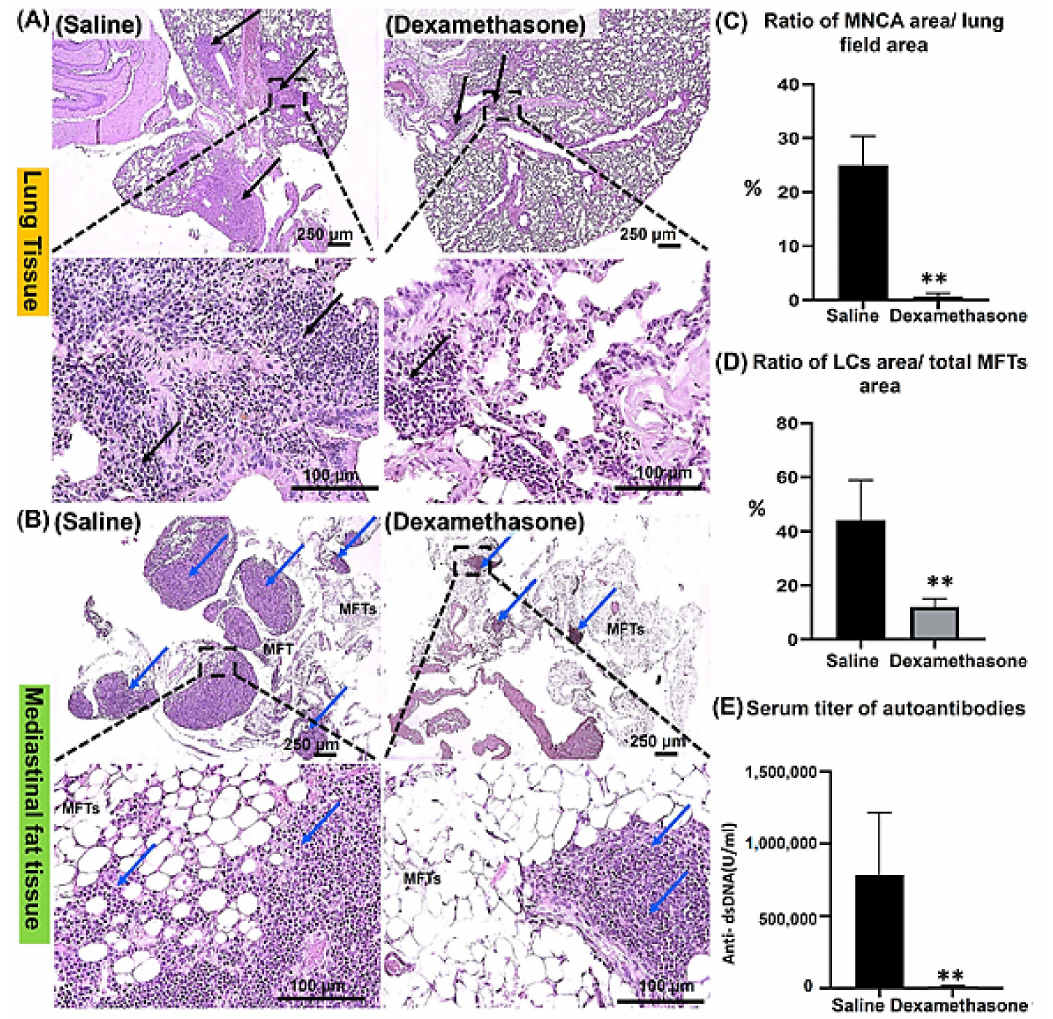
Figure 1. Analysis of the effect of dexamethasone on the degree of lung injury, development of mediastinal fat associated-lymphoid clusters (MFALCs), and autoimmunity in female Lpr mice. ( A , B ) HE staining of the lung ( A ) and mediastinal fat tissues “MFTs” ( B ) in saline and dexamethasone administered groups. Notice the mononuclear cellular aggregations “MNCA” (black arrows) and MFALCs (blue arrows) associated with the MFTs. ( C , D ) Graphs indicating the morphometrical data of the percentages for the ratios of the area of MNCA/area of the lung field (mm 2 ) and the area of LCs/the total area of MFTs (mm 2 ). ( E ) Graph indicating the serum levels of anti-double- stranded DNA autoantibodies. Highly significant values (**) were observed between the saline and dexamethasone groups ( p < 0.01), where n = 5 in each experimental group. Analysis was conducted using the Mann–Whitney U test. Data are presented as mean values ±